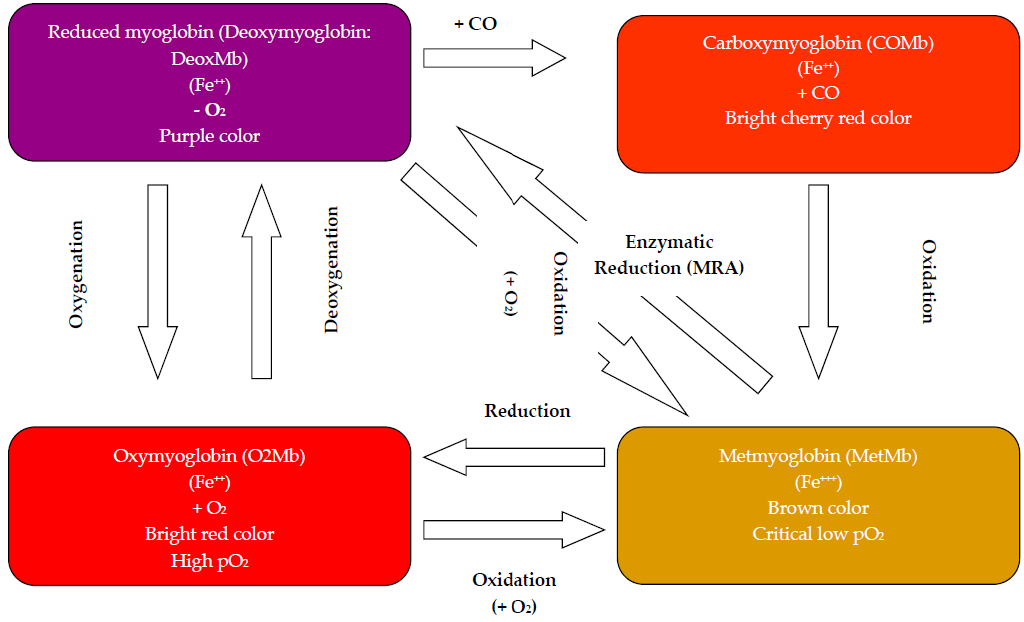
Figure 1. The cycle of color in fresh red meat.